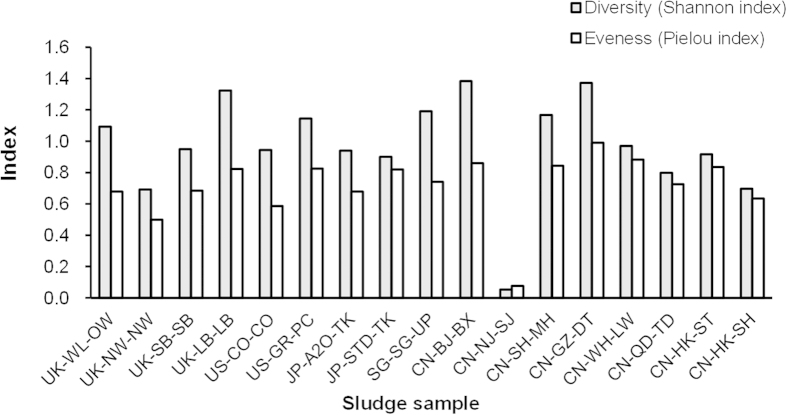
Diversity and evenness of the Accumulibacter lineage in the full-scale WWTPs indicated by Shannon index and Pielou index respectively.The indices were calculated from the relative abundances of the five Accumulibacter clades (normalized to total Accumulibacter ppk1 genes).